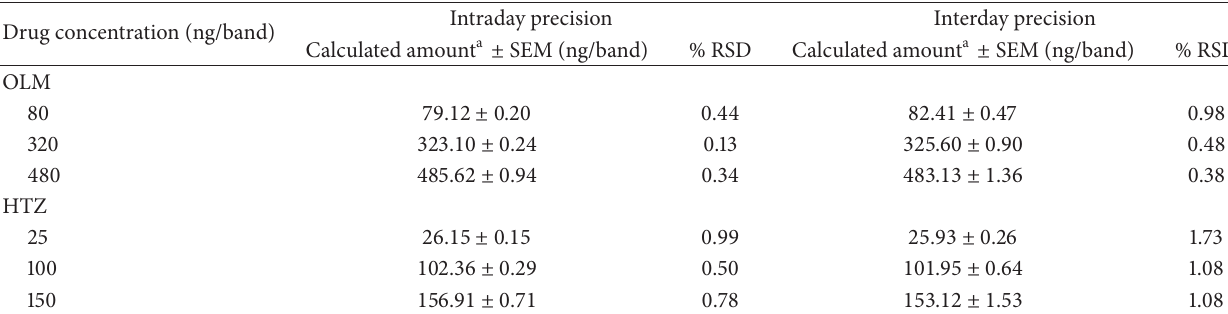
Table 2: Results of precision studies of proposed method.